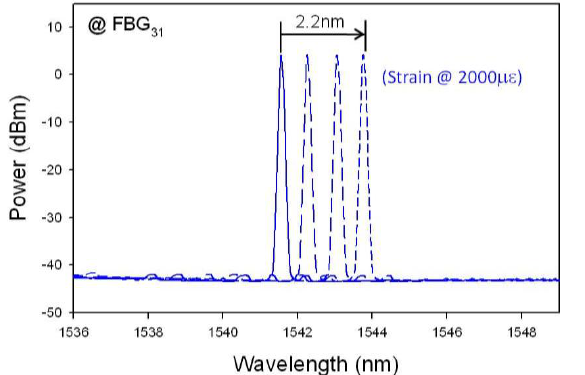
when the strain is applied. 31